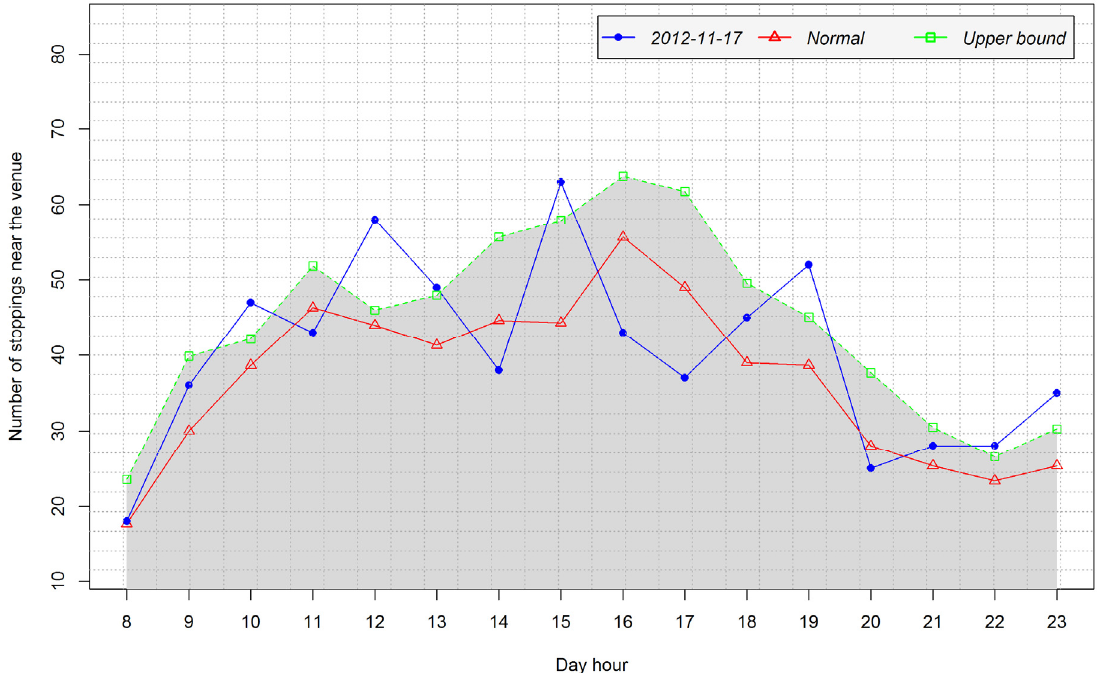
Figure 5. Temporal variation of the number of stoppings near the venue (P ), its normal value ( Q ), and its upper bound ( UP ) on a day without event.